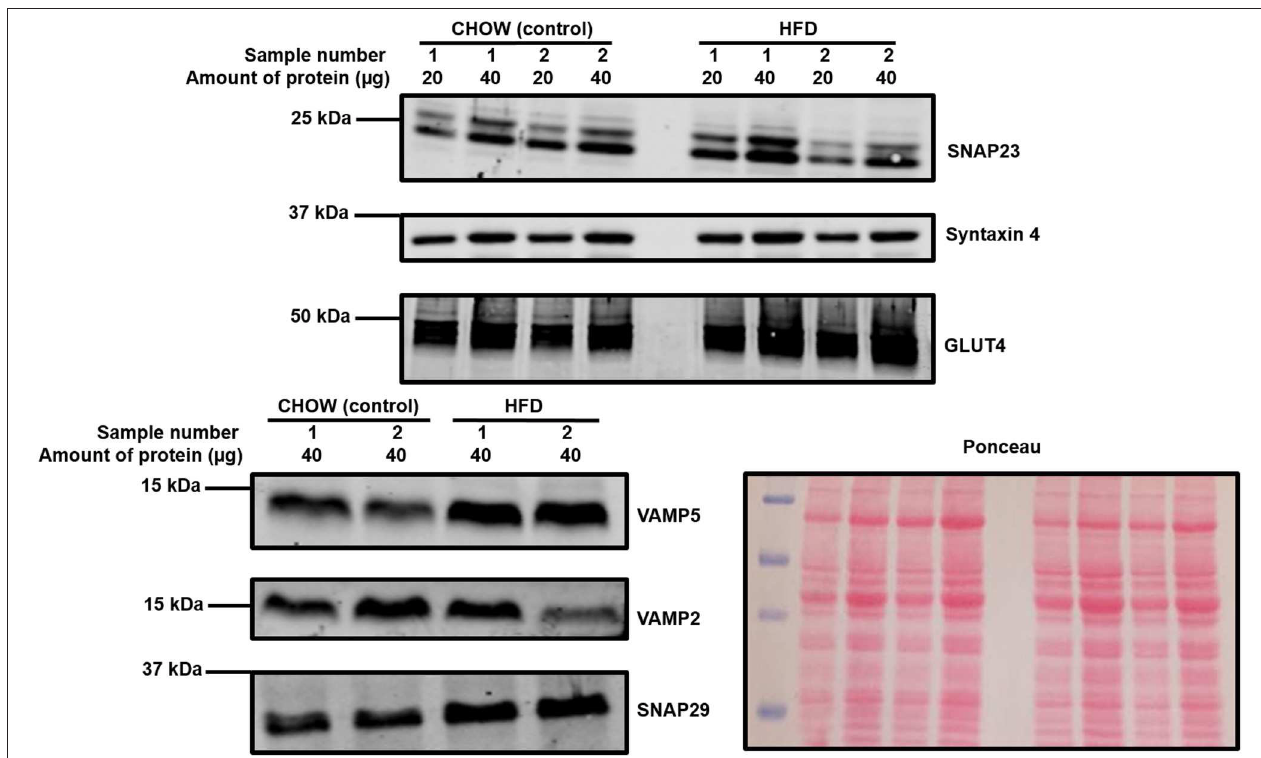
FIGURE 3 | Cardiac SNARE expression in HFD fed and control mice. Protein lysates were generated from HFD and control mouse hearts and subjected to SDS-PAGE and immunoblotting, probing for the expression of SNARE proteins and GLUT4. Representative immunoblots for selected proteins are shown together with Ponceau S staining, which was used as a loading control. Each sample is composed of lysates generated from 2 to 4 individual